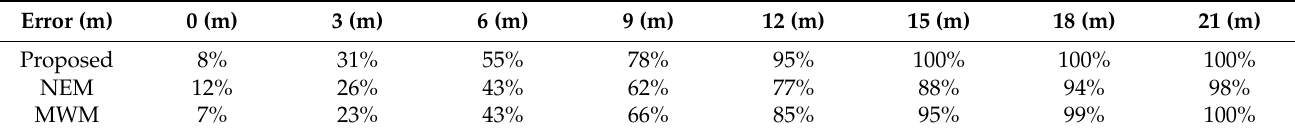
Table 16. KNN with diverse